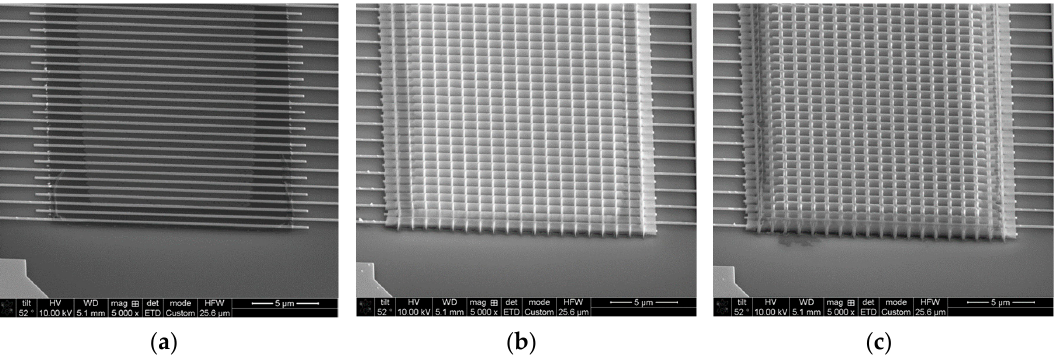
Sensors 2019 , 19 , 2061 8 of 11 Figure 7. Gas sensing application of infiltrated devices. ( a ) First generation device in a gas sensing chamber. ( b ) Data showing the change of current (%) as a function of time as the device is exposed to 5 ppm of formaldehyde and 5 ppm of NO 2 .